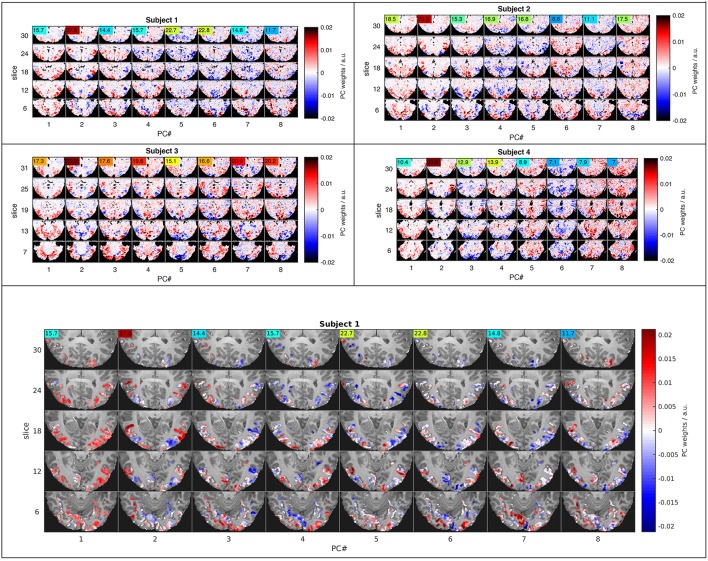
Functional connectivity patterns revealed by the eight leading principal components. Five representative slices (rows) representing projections of the eight highest-variance PCs (columns) in four subjects (small top panels) illustrate similarities across subjects and large-scale interactions between major subdivisions of the visual system. The ANOVA F-statistic (colored numbers) for each PC time course indicates, which components strongly influence LDA classification in PC space. The large bottom panel shows the feature space used for PCA in the context of the T1-weighted anatomy of the first subject.